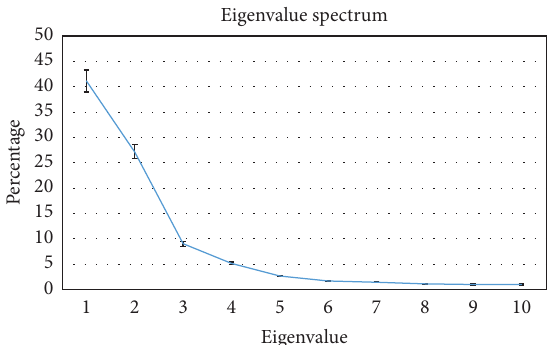
Figure 5: Variance percentages explained by eigenvalues of the frst ten leading modes of the fall rainfall in Vietnam in the period of 1981–2010. Te error bars display the sampling error at the 99% confdence level.